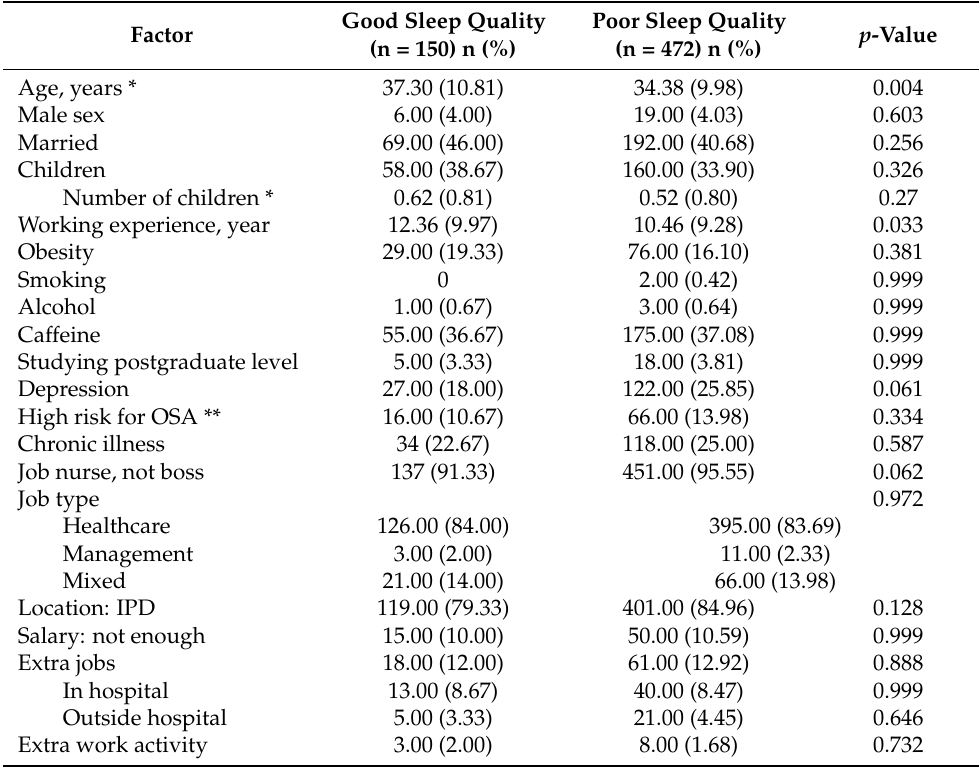
Table 1. Baseline characters and job characters of nurses categorized by sleep